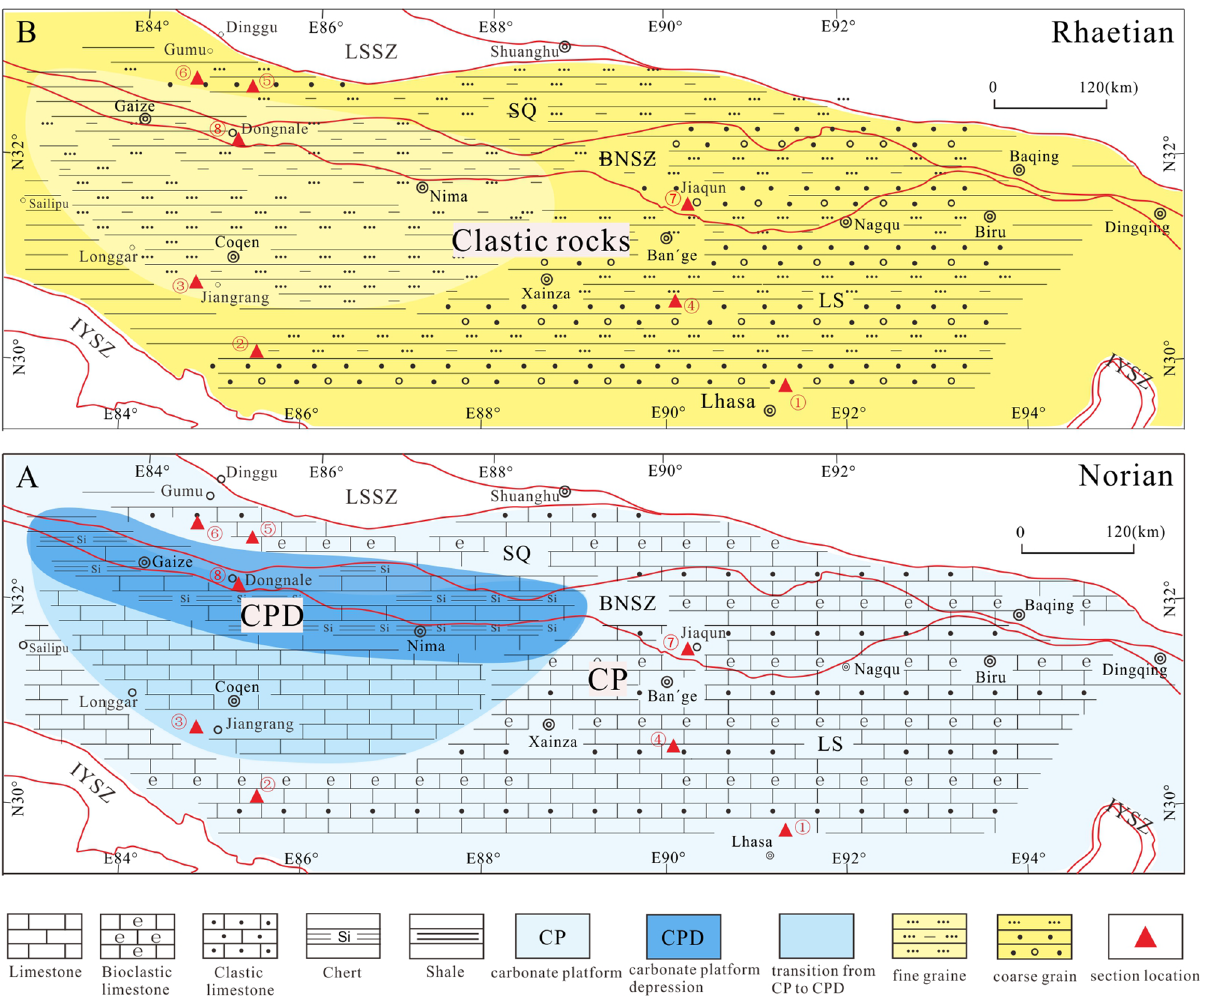
Figure 4. The Norian (A) and Rhaetian (B) sediments in the BNSZ, Lhasa Terrane, and South Qiangtang Terrane. ① -Mailonggang section (conodonts) 30 ; ② -Yawa section (conodonts and corals) 32 ; ③ -DibuCo section (conodonts) 31 ; ④ -NamuCo section (corals) 33 ; ⑤ , ⑥ -sections within the South Qiangtang Terrane (corals) 34 ; ⑦ -DaruCo section (corals) 12 ; ⑧ -ZhaxicobuCo section (conodonts; this paper); LS Lhasa Terrane, SQ South Qiangtang Terrane, LSSZ LongmuCo-Shuanghu Suture Zone, BNSZ Bangong-Nujiang Suture Zone, IYSZ Indus-Yarlung Zangbo Suture Zone. Red solid lines define boundaries between different tectonic